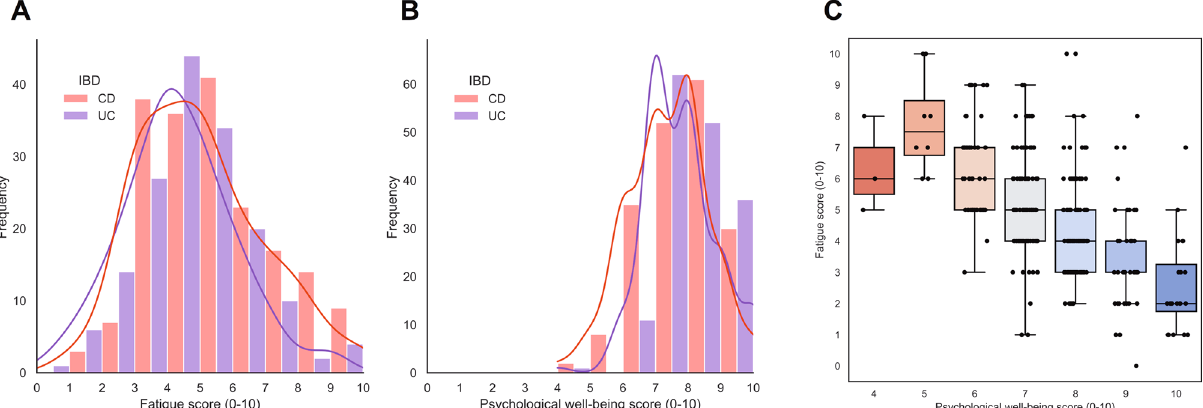
Figure 1. ( A ) Patient-reported fatigue scores follow a rather normal distribution for patients with CD (red) and UC (purple). ( B ) Patient-reported psychological well-being scores show a negative (left-) skewed distribution. ( C ) Boxplots of fatigue scores plotted against psychological well-being scores, demonstrating that fatigue inversely correlates with psychological well-being.